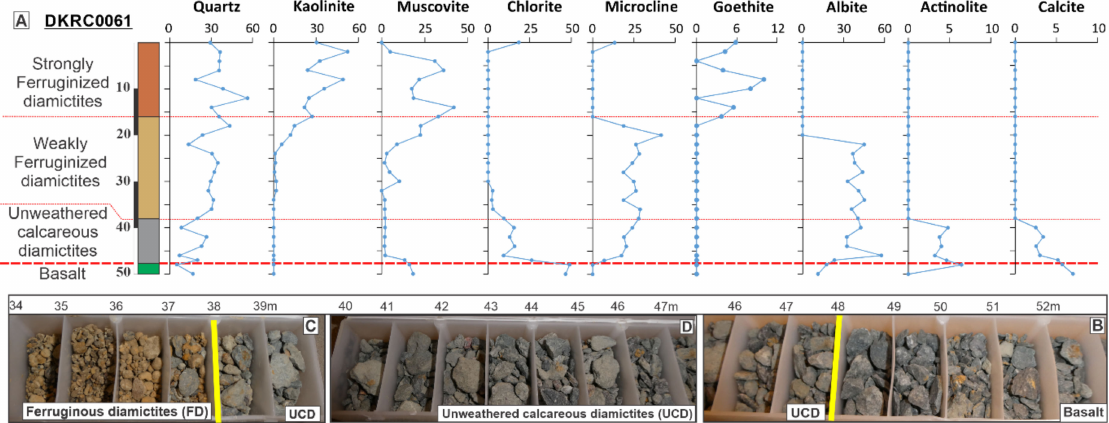
Figure 6. ( A ) XRD analysis of 27 samples from drill hole DKRC0061. ( B – D ) The Permian cover consists of unweathered calcareous diamictites (UCD) and ferruginized diamictites (FD) over unweathered basalt. Chlorite, actinolite, calcite, albite, and microcline dominate in the basalt and the unweathered diamictites. Albite and microcline resist weathering the weakly ferruginized diamictites. Kaolinite, muscovite, and goethite dominate the strongly ferruginized